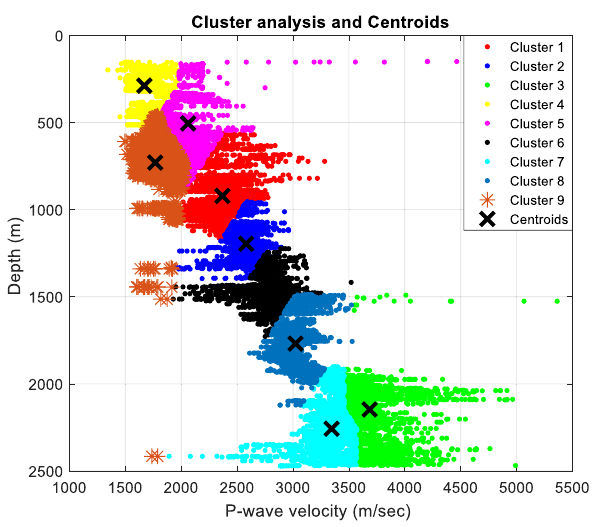
Fig. 5 Well-2 cluster analysis of P-wave velocity